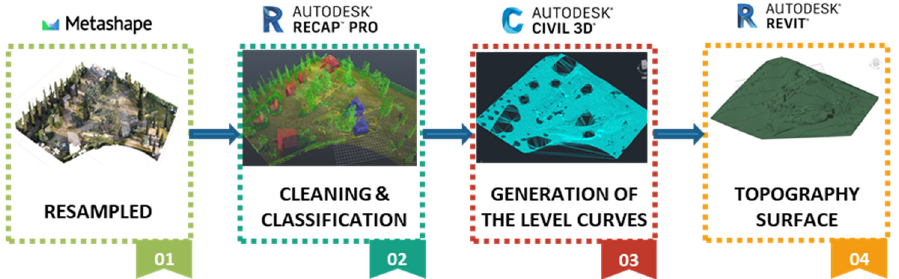
Figure 17. Diagram of the working process of the topography modelling from the obtained point cloud to the Revit topographic surface.